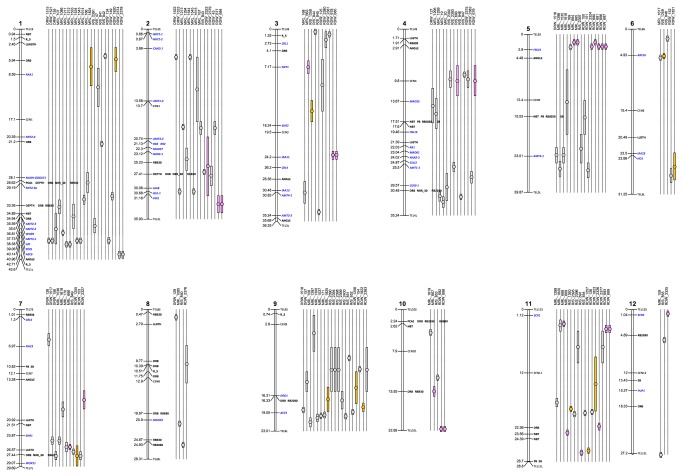
Relative positions of significant markers, genes and QTLs for corresponding root traits.Significant markers are in black and genes in blue on the chromosome bodies .QTLs in orange and pink were detected in japonica x japonica and indica x indica mapping populations respectively. QTLs in grey were detected in other population types (indica x japonica, japonica x indica or japonica x aus). MRL = Maximum root length DRB= deep root biomass; RB = root biomass; R_S =root to shoot ratio. Data were extracted from the rice module from TropgeneDB for the root genes ("EURoot genes" set) and the QTLs (http://tropgenedb.cirad.fr/tropgene/JSP/interface.jsp?module=RICE). The QTL numbers correspond to their ID in this database.